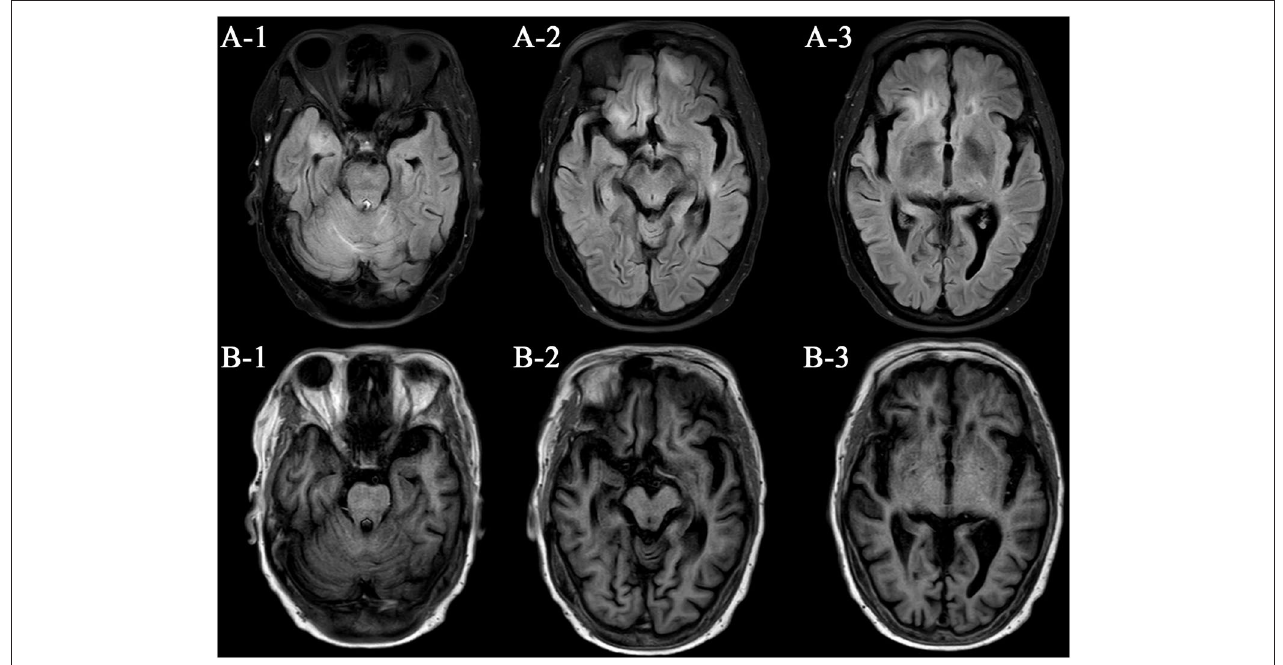
FIGURE 1 | Neuroimaging presentation. (A) Flair images; (B) T1